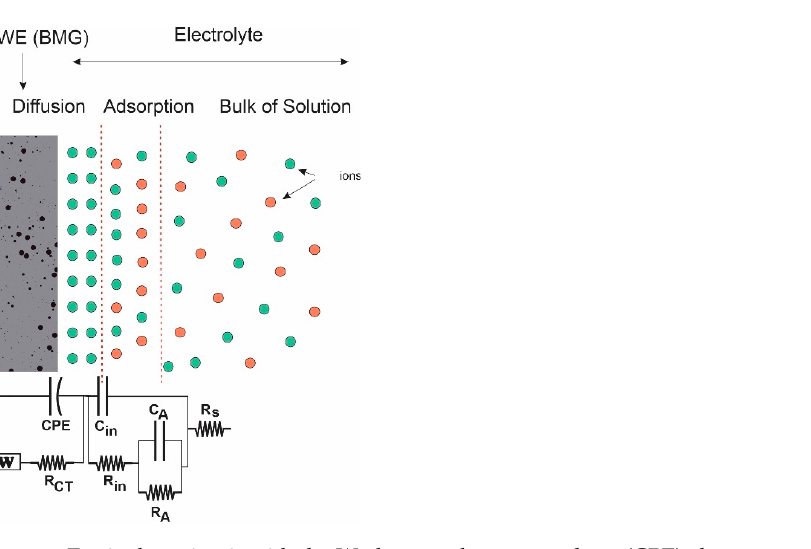
1 𝑐 (cid:3016)(cid:3029) 𝐷 (cid:3016)(cid:2869) (cid:2870)⁄ + 1 𝑐 (cid:3019)(cid:3029) 𝐷 (cid:3019)(cid:2869) (cid:2870)⁄ (cid:3441) where R and F are the gas and Faraday constants, D is the diffusion coefficient and c is the concentration of elements in the bulk. The indices O and R denote the oxidized and re- duced elements, respectively. In the Nyquist plot, the Warburg impedance, associated with restricted, controlled diffusion, is extremely noticeable under EIS as a straight line with a phase of 45°. In Figure 8, the Warburg vertical slope is not 45°. Figure 10a shows the Warburg plot. At the lower frequencies where Warburg impedance leads, the slope of |Z| should have been − 0.5 (dif- ferent from the pure capacitor, which had a slope equal to − 1). Here, the calculated slope was − 0.78. When charge-transfer resistance and double layer capacitance are present, they hide the Warburg impedance element attribute and become difficult to identify. At higher frequencies, charge-transfer resistance leads, and the phase angle becomes 0°. Figure 10b is characteristic to Warburg impedance. Both the real and imaginary parts of Z are plotted vs. 1 𝜔 (cid:2870) ⁄ . The lines are straight and parallel, and the slope is equal to Warburg’s constant, σ . The intersection of real impedance with the Z-axis is R CT , while the imaginary imped- ance line must intersect with the Z-axis at the origin. These two parallel lines are usually used to identify the Warburg element.